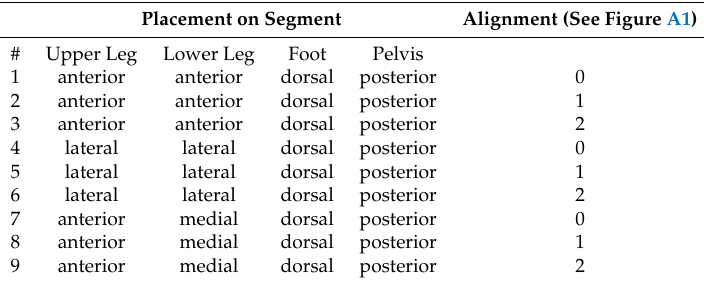
Table A7. IMU configurations used during the recording of dataset B